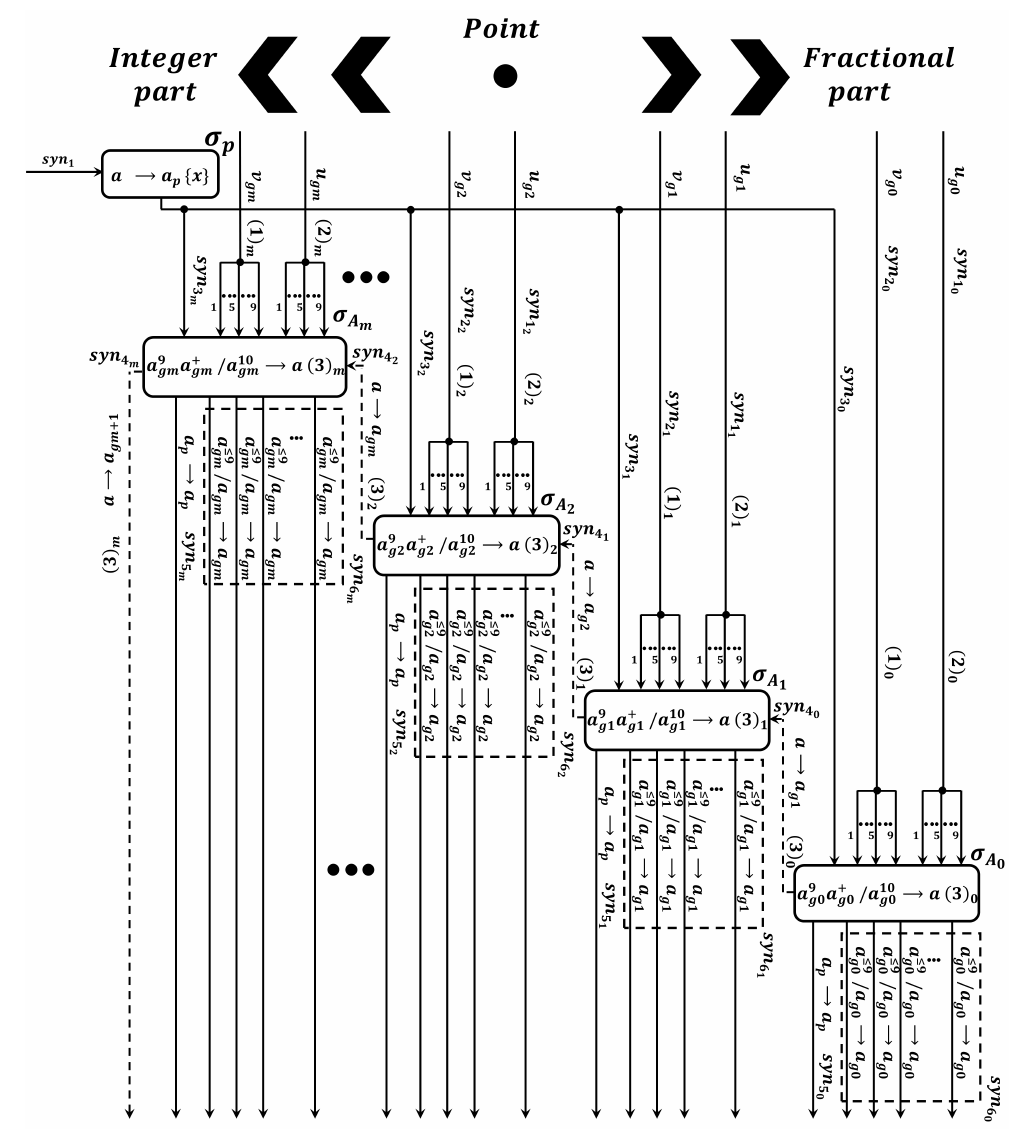
Figure 9. General structure of the proposed floating-point neural